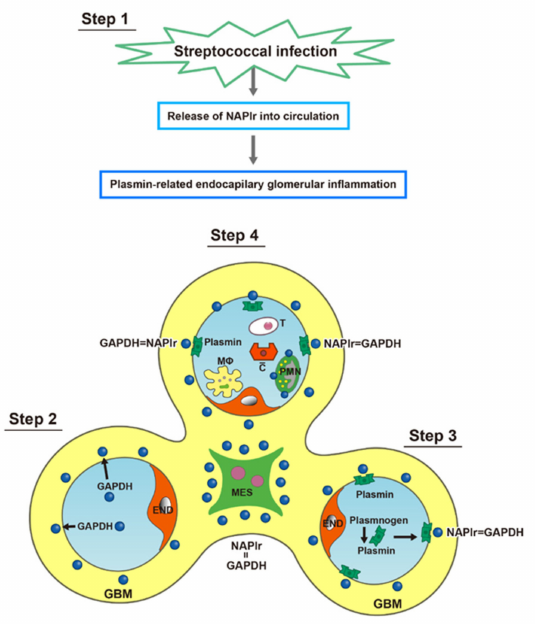
Figure 9. Schematic representation of the proposed mechanism for PSAGN. GAPDH: glyceraldehyde- 3-phosphate dehydrogenase, GBM: glomerular basement membrane, END: endothelial cell, MES: mesangium, NAPlr: nephritis-associated plasmin receptor, M Φ : macrophage, PMN: polymorphonu- clear neutrophil, PSAGN: post-streptococcal acute glomerulonephritis. This schema is modified and cited from a previously published paper